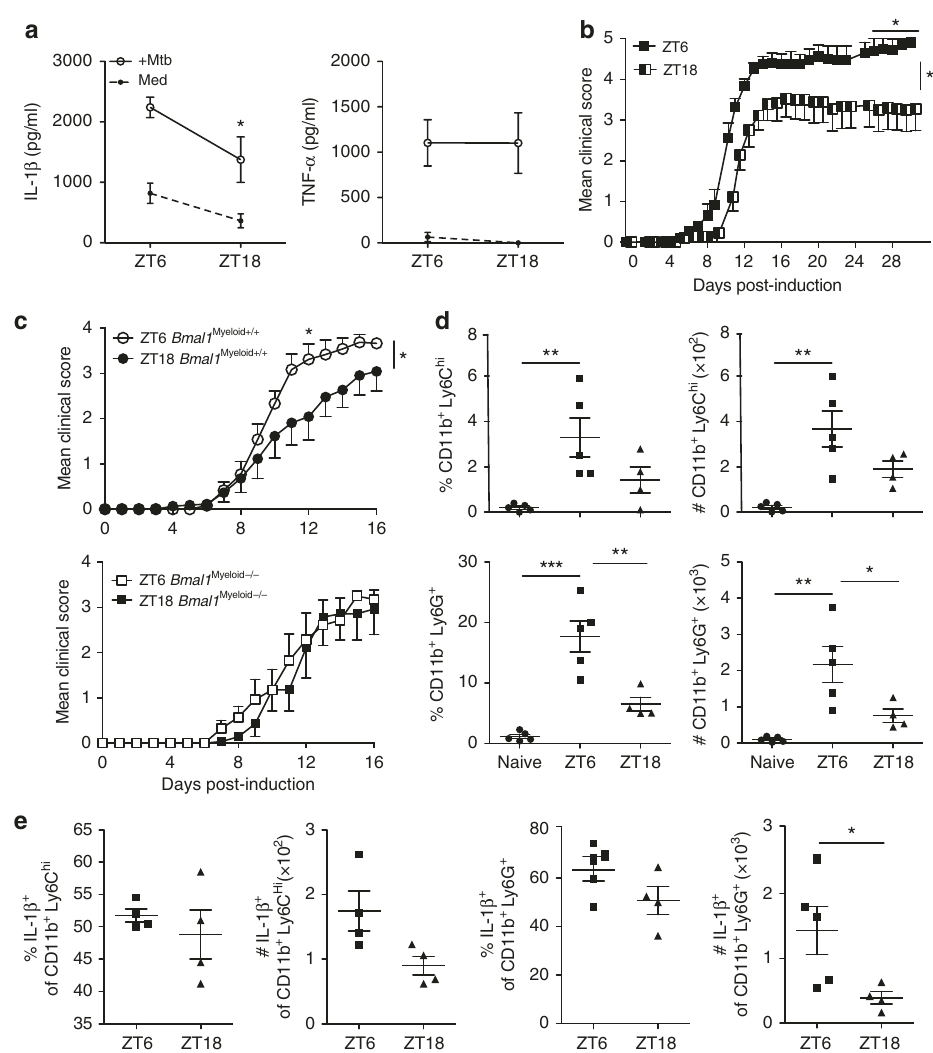
Fig. 6 Severity of EAE is dependent upon time-of-day at point of immunization. a Lymph node (LN) cells isolated at either ZT6 or 18 were stimulated with medium or Mycobacterium tuberculosis (MTB) (100 µ g/ml). Supernatants were tested by ELISA for IL-1 β and TNF after 24 h. b Daily clinical score for myelin oligodendrocyte glycoprotein (MOG 35 – 55 ) + complete Freund ’ s adjuvant (CFA) + pertussis toxin (PT)-induced EAE in female C57BL/6 mice, immunized at either ZT6 or ZT18. Statistics by Kruskal – Wallis test on indicated days of 12 mice per group and Mann – Whitney test of area under the curve. c EAE clinical scores in Bmal1 Myeloid + / + and Bmal1 Myeloid − / − female mice immunized with MOG+ CFA and PT at either ZT6 or ZT18. Statistics by Kruskal – Wallis test on indicated days for 7 – 12 mice per group and Mann – Whitney test of area under the curve. d , e Peritoneal exudate cells were removed from 3 d MOG 35 – 55 + CFA + PT ZT6 or ZT18-immunized or naive female C57BL/6 mice ( n = 4 – 5). d FACS was performed directly ex vivo gating on CD11b + cells and examining Ly6C hi and Ly6G + populations ( n = 4 – 5). e Intracellular FACS for IL-1 β production gating on CD11b + Ly6C hi or CD11b + Ly6G + populations ( n = 4 – 5). Statistics were performed by Mann – Whitney U test ( a , d , e ). All data is presented as means ± standard error of the mean (SEM). * p < 0.05; ** p < 0.01; *** p < autoimmunity thus providing opportunities to enhance circadian function or time-of-day drug-targeting strategies to alleviate autoimmune disease.